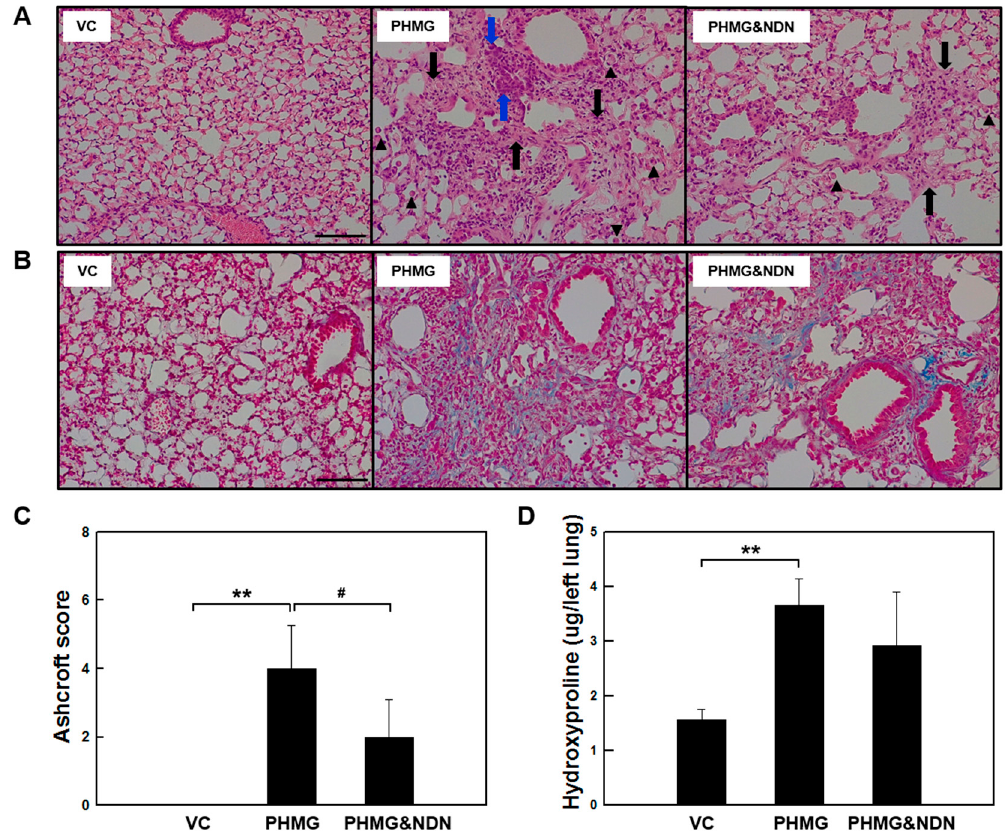
Figure 3. Effect of NDN on histopathological analysis and HC of the lung tissues. Representative histological sections from lung tissues. The lung sections were stained with H&E ( A ) and MT ( B ). The lung sections from the VC group showed a normal architecture. Black arrows indicate granulomatous inflammation/fibrosis, blue arrows indicate bronchioloalveolar epithelial hyperplasia (BEH), and black triangles indicate infiltration of alveolar macrophage. Scale bar represents 100 µ m; ( C ) Ashcroft score was compared among the experimental groups. ( D ) Collagen content in the homogenates of the lung tissues was measured using a hydroxyproline assay ( n = 6/group). Results are expressed as the means ± SD. ** p < 0.01 vs. VC group, # p < 0.05 vs. PHMG group. Table 1. Quantitative histopathological assessment of the lung sections.